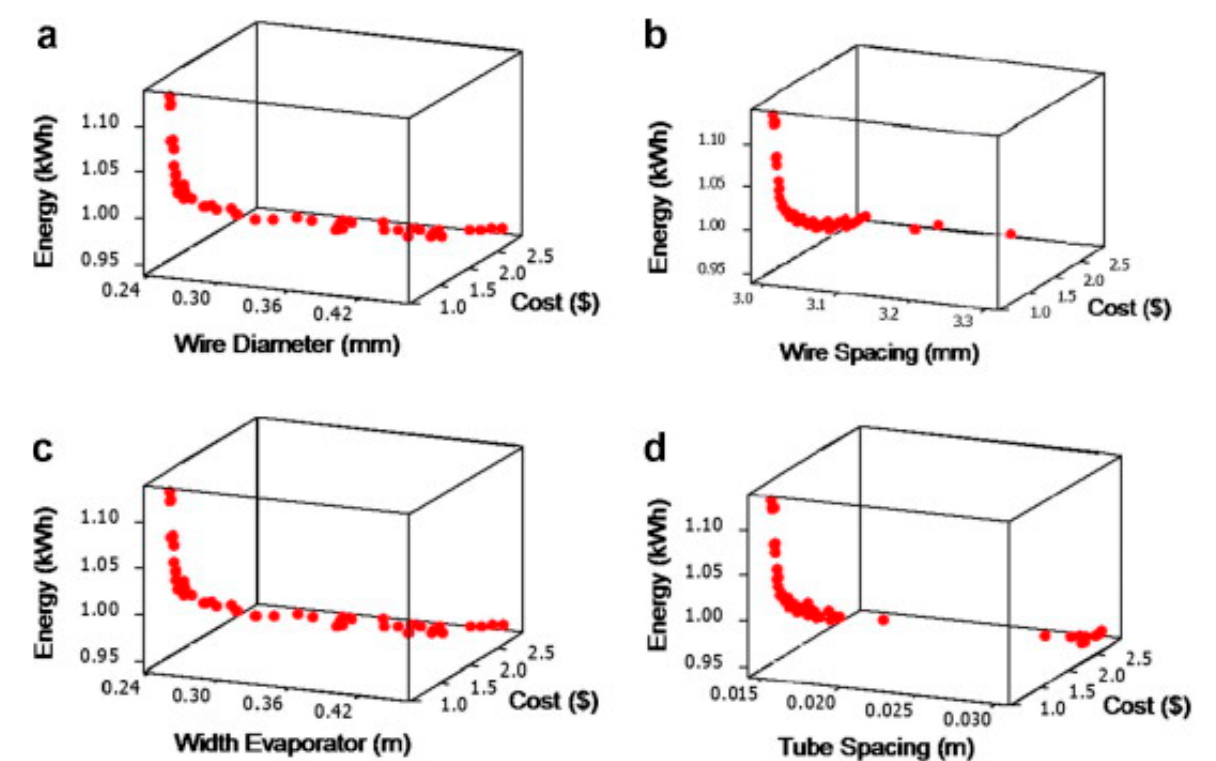
Figure 25. Design variables’ impact such as wire diameter ( a ), wire spacing ( b ), width evaporator ( c ) and tube spacing ( d ) on design criteria within optimal solutions [107].